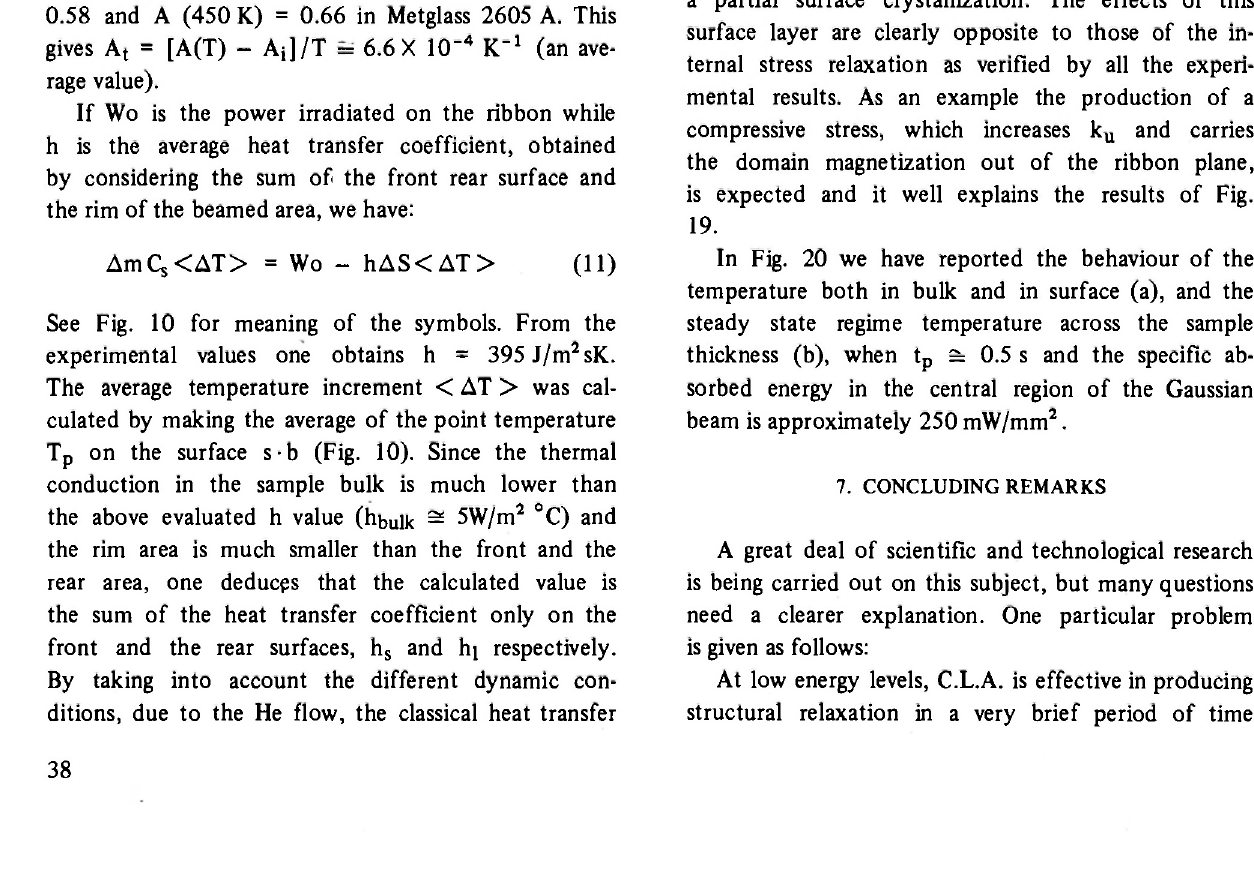
Fig. 19. The angle Ψ (between the ribbon plane and the mag- netic moment of the Fe atoms) versus the interaction time of C.L.A. Ψ was evaluated from the area ratios of the Mossbauer spectrum